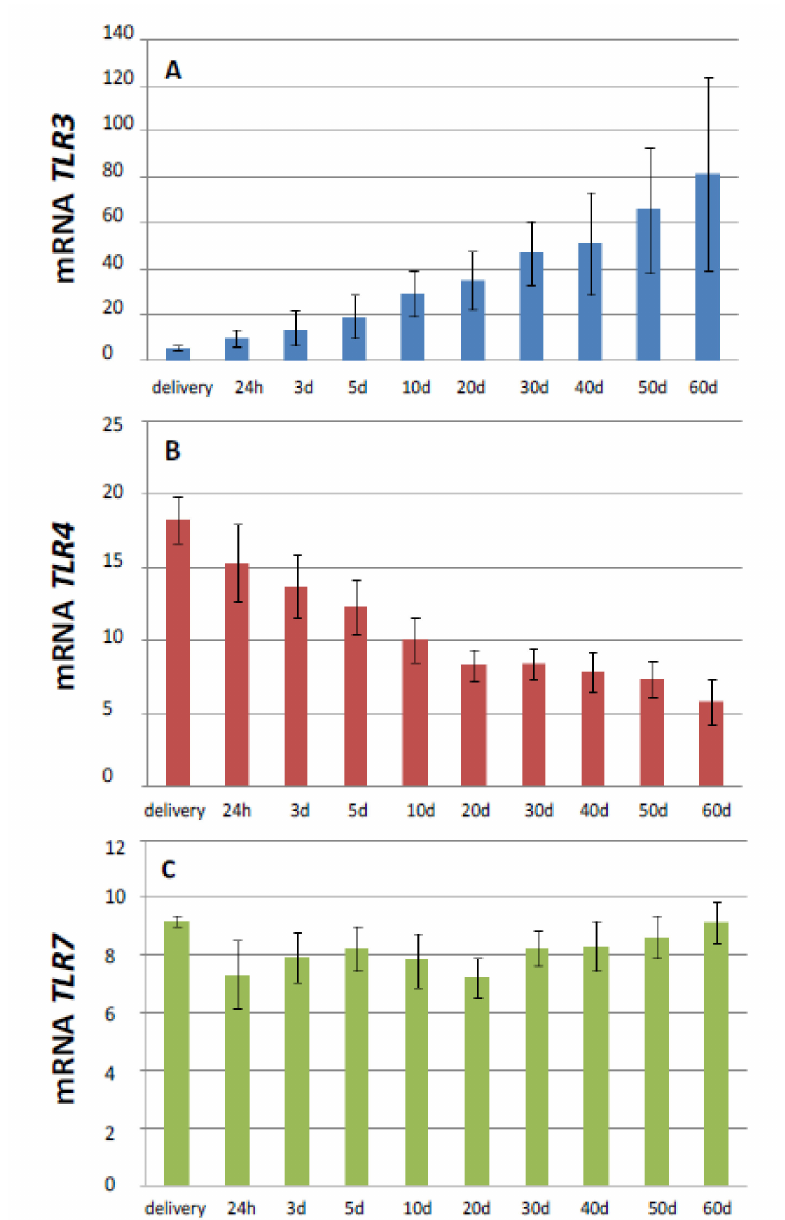
Figure 1. Trends in the change of TLR3 ( A ), TLR4 ( B ), and TLR7 ( C ) expression during foals’ growth. Delivery, sample collected at delivery; 24 h, sample collected 24 h after delivery; 3 days, sample collected every 3rd day after delivery; 5 days, sample collected every 5 days after delivery; 10 days, sample collected every 10 days after delivery; 20 days, sample collected every 20 days after delivery; 30 days, sample collected 30 days after delivery; 40 days, sample collected every 40 days after delivery; 50 days, sample collected every 50 days after delivery; 60 days, sample collected 60 days after delivery. The means are reported with their standard